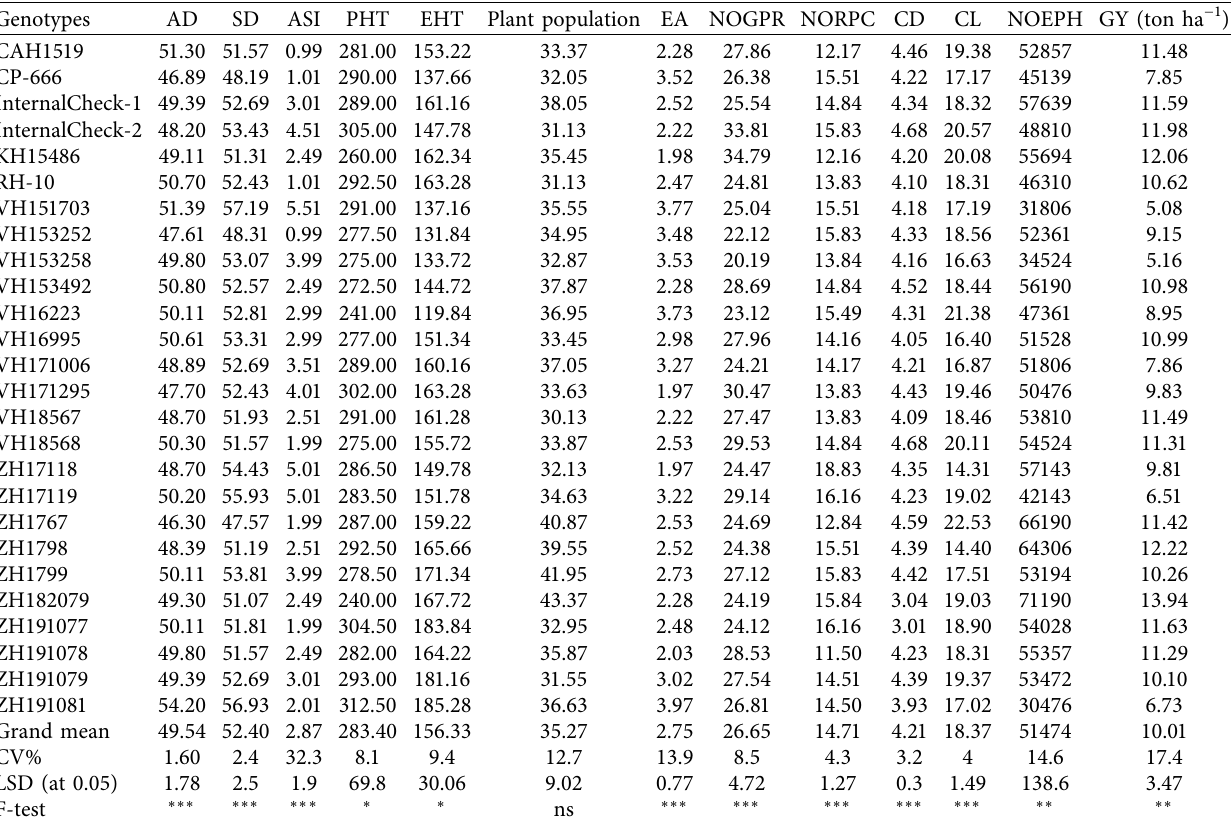
Table 2: Mean performance and analysis of the variance of the 26